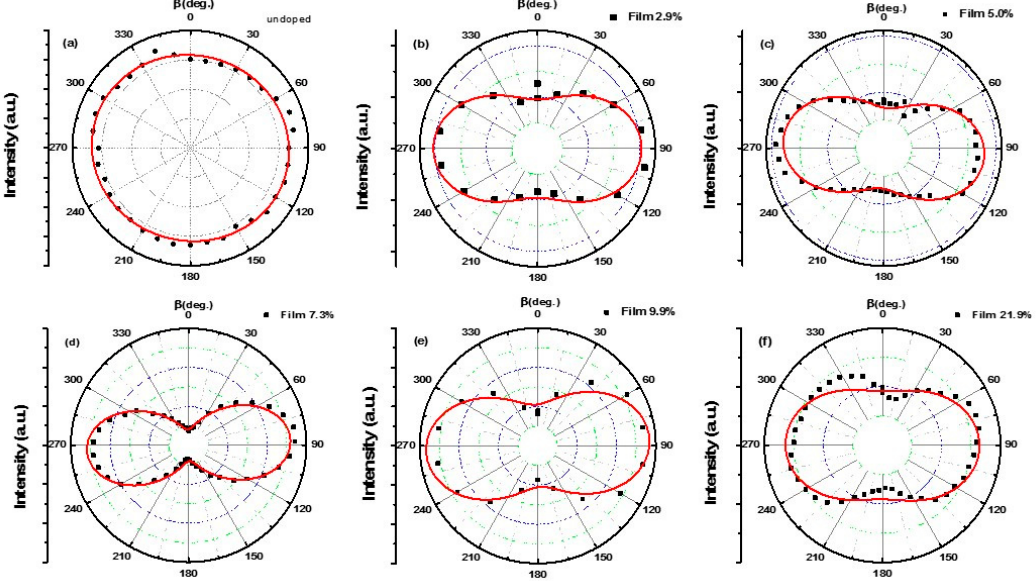
Figure 5. The normalized SHG intensity as the polarization angle, θ , changed for GZO films with di ff erent doping concentrations ( a ) 0; ( b )2.9%; ( c ) 5.0%;( d ) 7.3%; ( e ) 9.9%; ( f ) 21.9%. The experimental data are shown as dots and the solid curves show the theoretical fits.